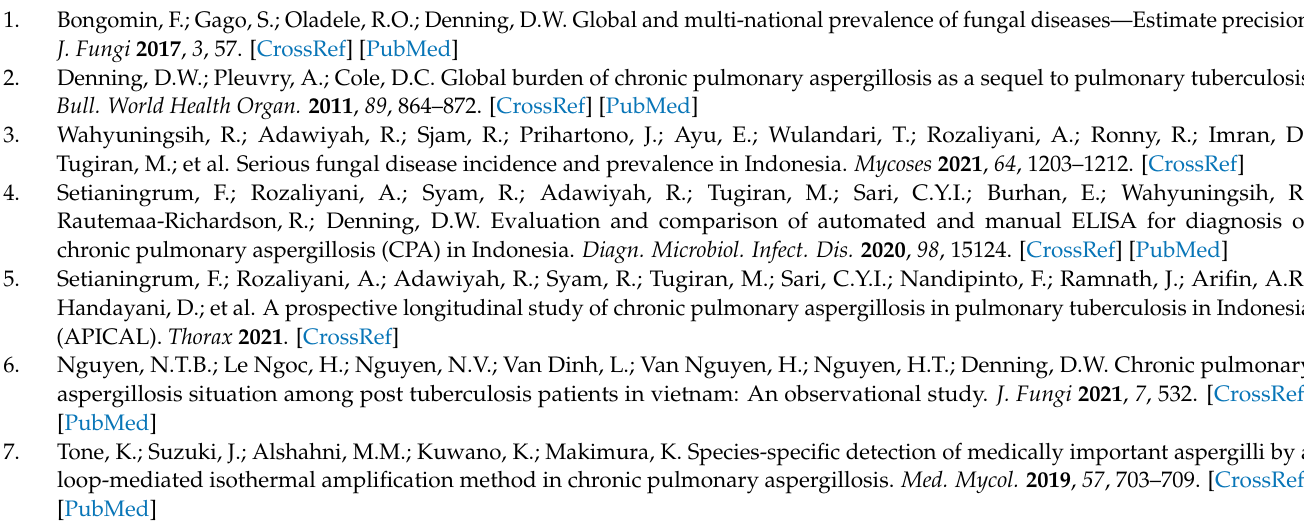
Table S3. The antifungal susceptibility profiles from the Flavi section. Table S4. The antifungal susceptibility profiles from the Nigri